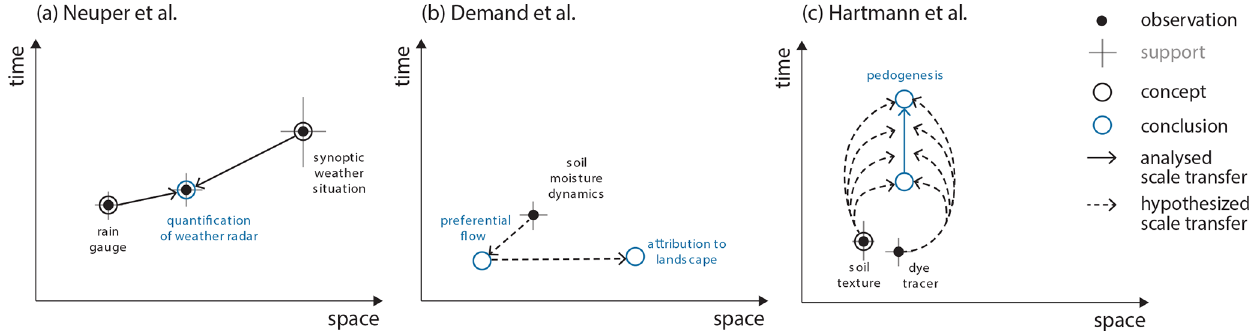
Figure 2. Examples of scales of observations, concepts and conclusions and how scale transfer is